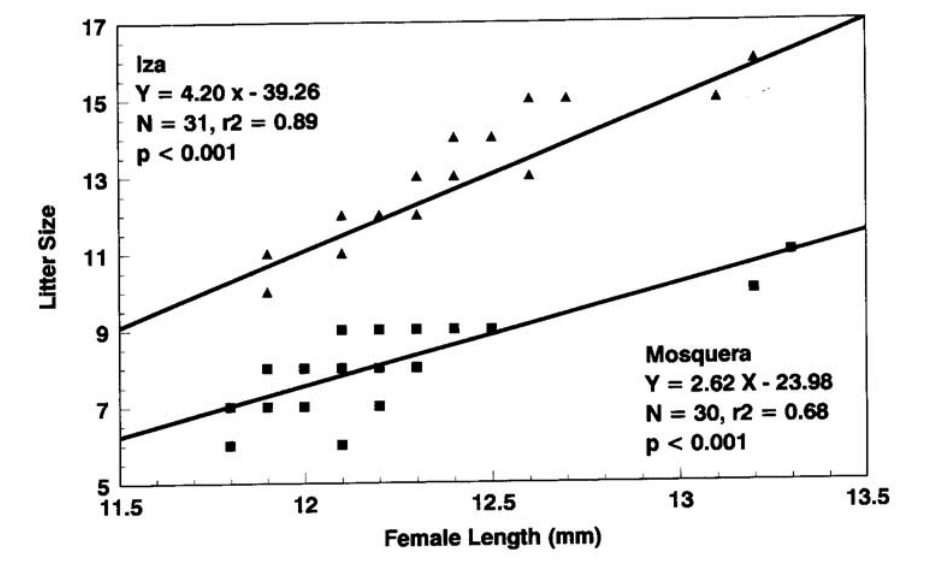
Figure 22. Correlation between clutch size and female body size for Iza and Mosquera populations of Tityus columbianus (from Lourenço et al ., 29).